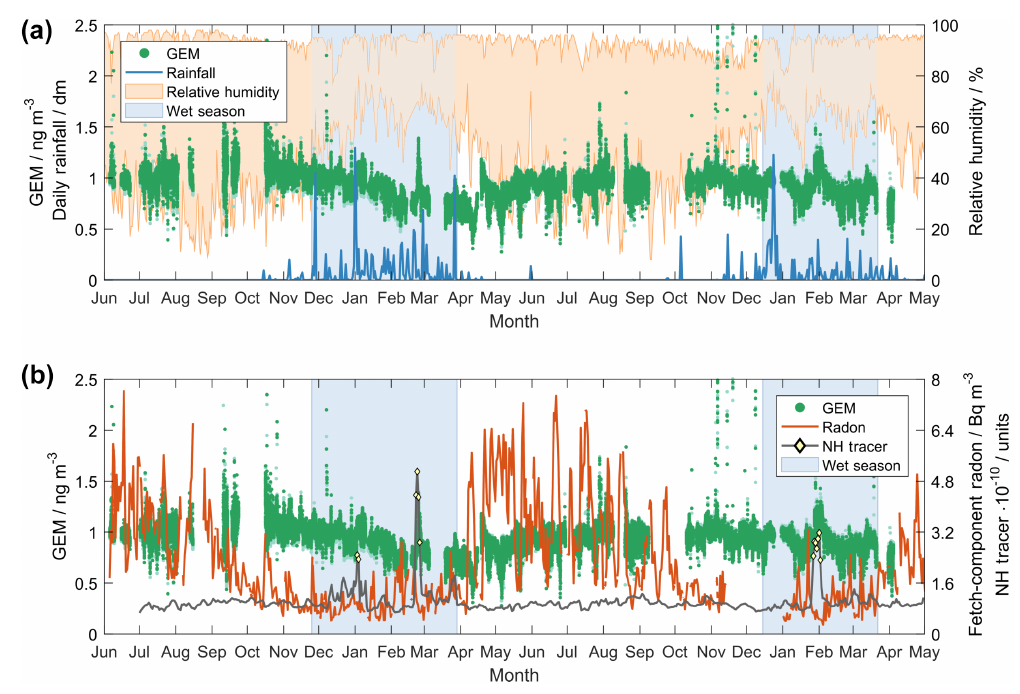
Figure 2. (a) 5min GEM data, daily rainfall, and daily min/max relative humidity values plus wet-season ranges as defined by Smith et al. (2008). (b) 5min GEM, hourly fetch-component radon and daily NH tracers. Days defined as NH-influenced are marked with diamonds.